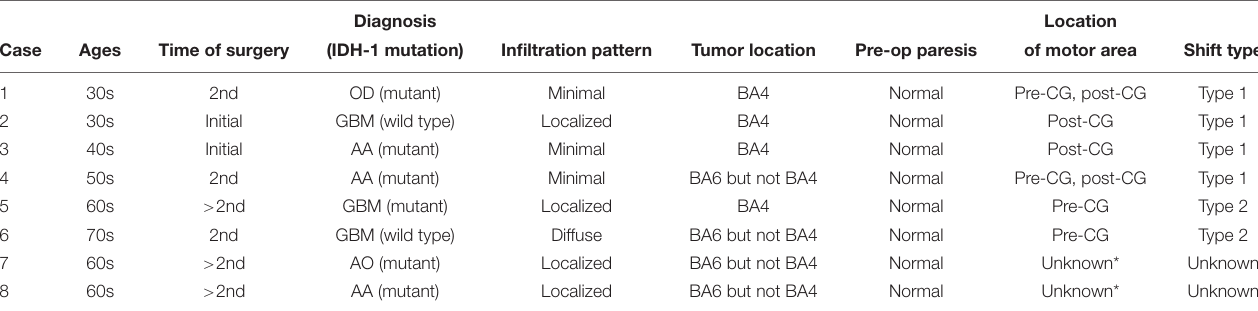
TABLE 2 | Patients’ characteristics whose motor function